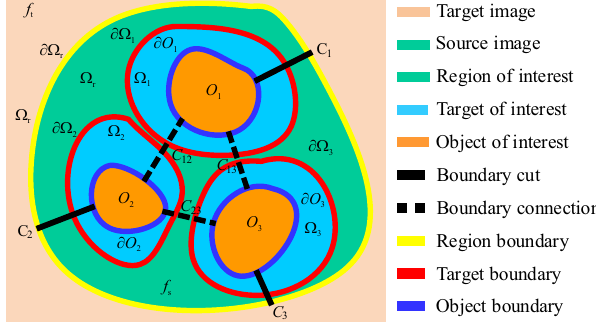
Optimal editing region selection. A region of interest from the source image may include one or more objects of interest. Optimal editing region selection requires finding optimal targets of interest which contain objects of interest, to minimize local structure mismatches. As optimal target boundaries should not intersect each other, we break the band connectivity with several shortest boundary cuts or connections, giving an effective algorithm for finding the shortest closed